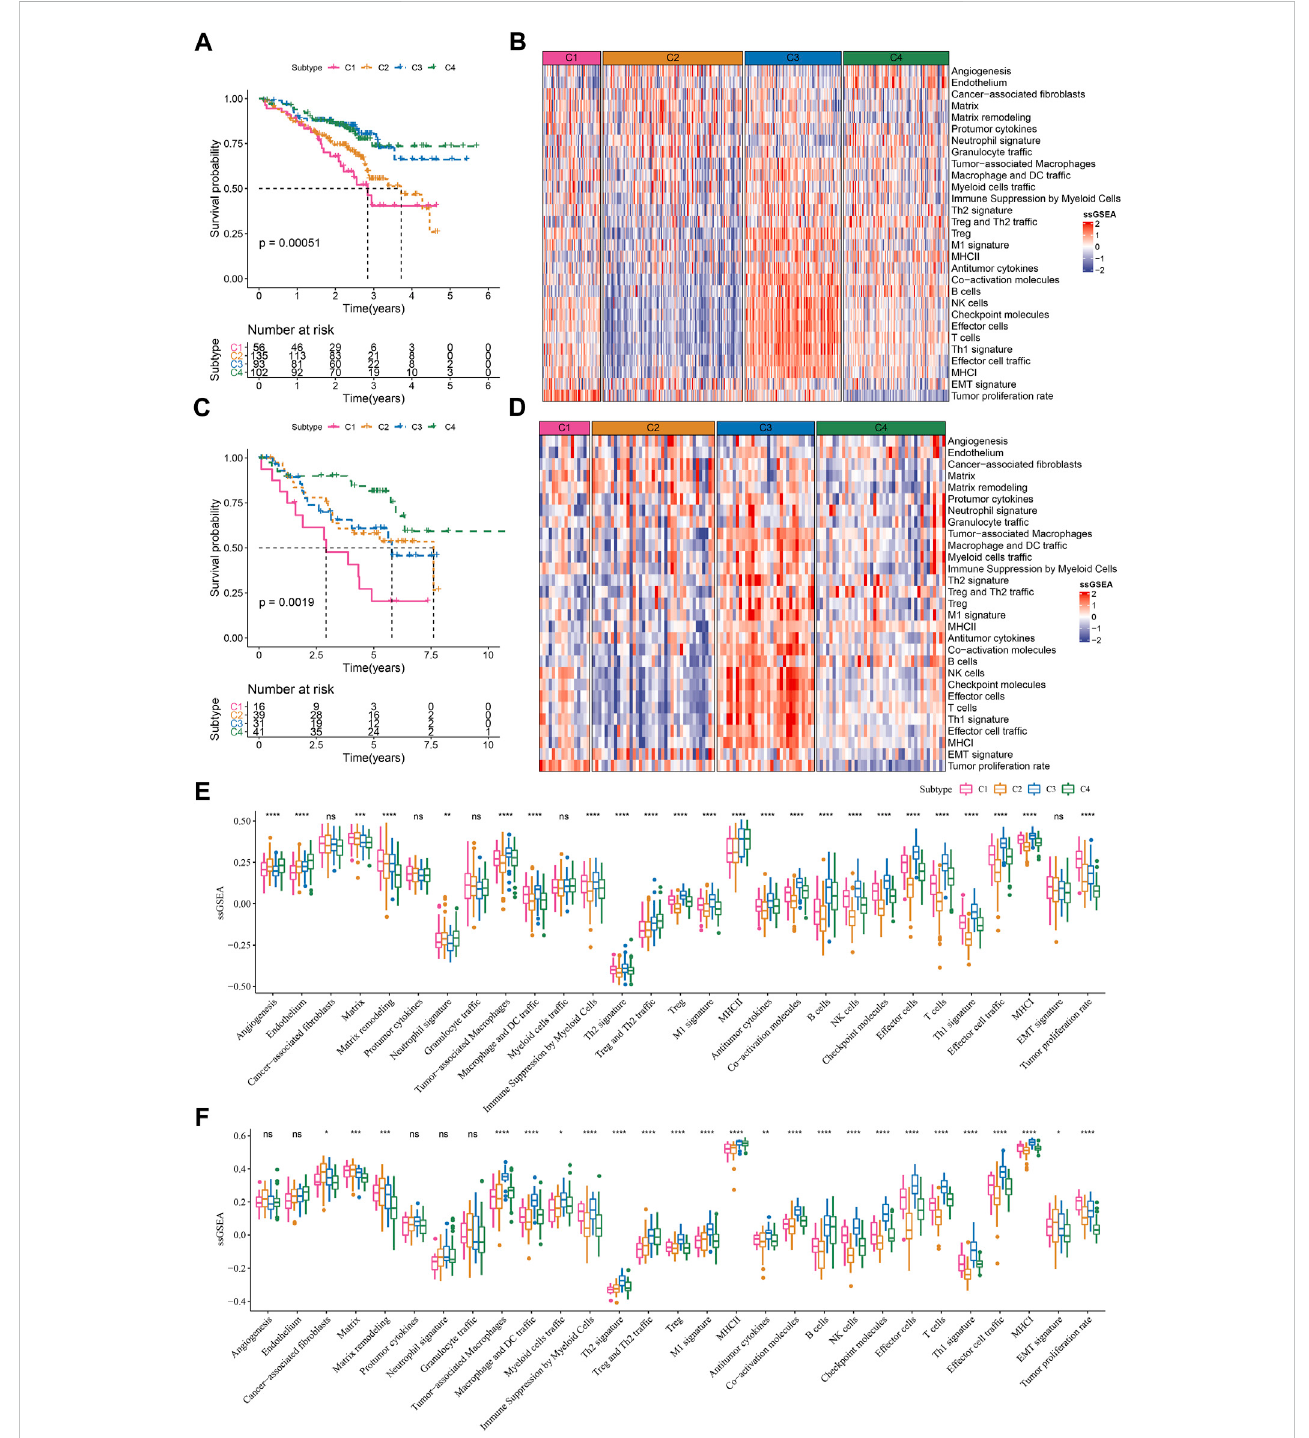
FIGURE 6 ValidationofTME-basedmolecularsubtypesintwoexternaldatasets (A) SurvivalplotoffoursubtypesinGSE72094dataset (B) Theheatmapshowedthe enrichment of TME signatures in GSE72094 dataset (C) Survival plot of four subtypes in GSE50081 dataset (D) The heatmap showed the enrichment of TME signatures in GSE50081 dataset (E – F) The ssGSEA score of 29 TME signatures in four subtypes in GSE72094 and GSE50081 datasets. ns, not signi fi cant. * p < .05, ** p < 0.01, *** p < 0.001, **** p <